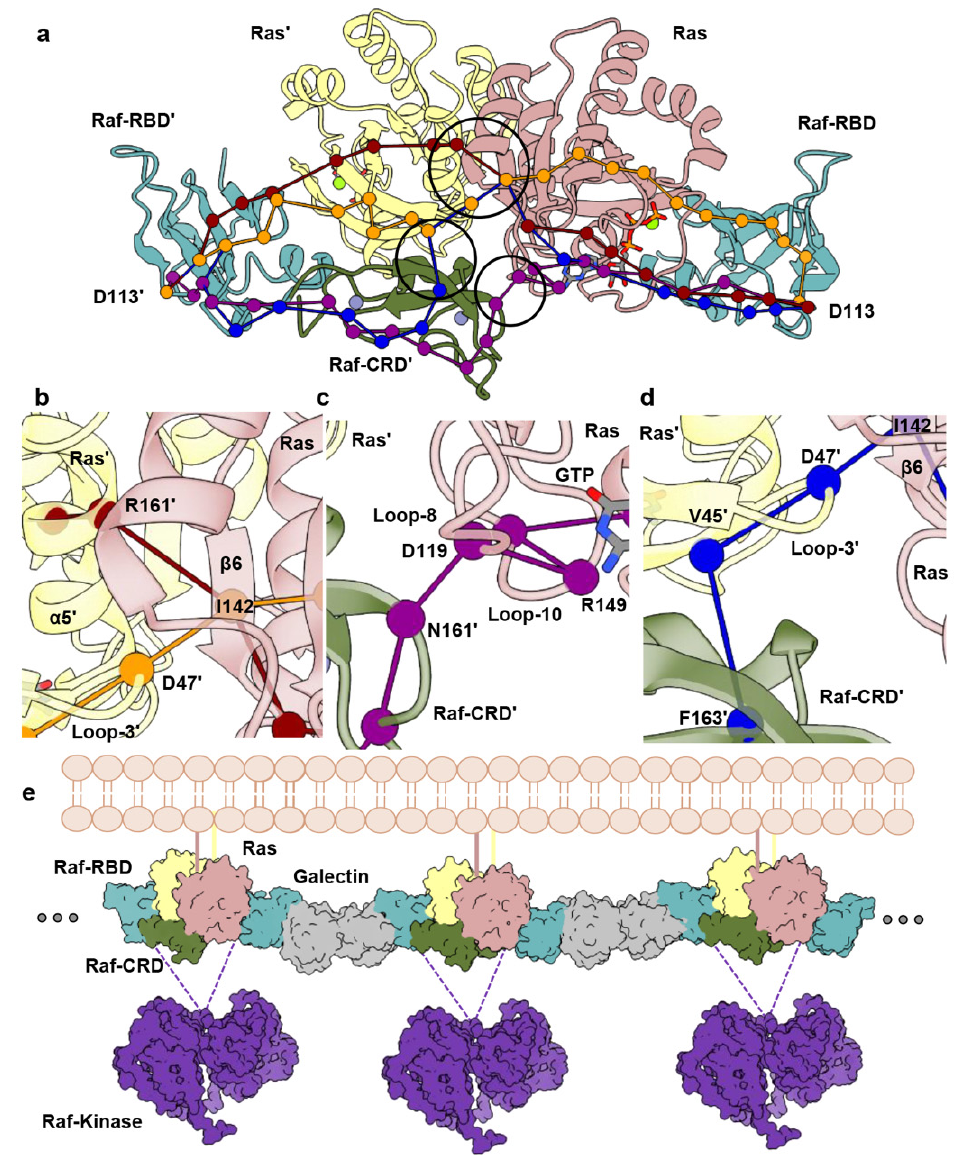
Figure 3. Dynamical network analysis performed for HRas–CRaf-RBD_CRD dimer simulations. ( a ) Allosteric paths calculated between D113 and D113’ of the Raf-RBD molecules. ( b ) Close-up view showing path for intermolecular information involving Ras loop 3/ β 6 (orange) and Ras α 5/ β 6 (red) across the Ras dimerization interface. ( c ) Close-up view showing path for intermolecular information involving Raf-CRD/Ras loop 8 (purple). ( d ) Close-up view showing path for intermolecular information involving Raf-CRD/Ras interswitch region (blue). ( e ) Proposed Ras–Raf–Galectin assemblies adapted from Packer et al. [8] with inclusion of the Raf-CRD. Galectin (grey) (PDB ID 3W58) and Raf-kinase (purple) (PDB ID 6Q0J) were downloaded from the Protein Data Bank. The scaffold protein 14-3-3 stabilizes the Raf kinase dimer (not shown). Given that the structure of the CR2 is unknown, it is also possible that kinase domains from distinct Ras–Raf-RBD_CRD dimers bridged by Galetin come together to form the activated Raf dimer.